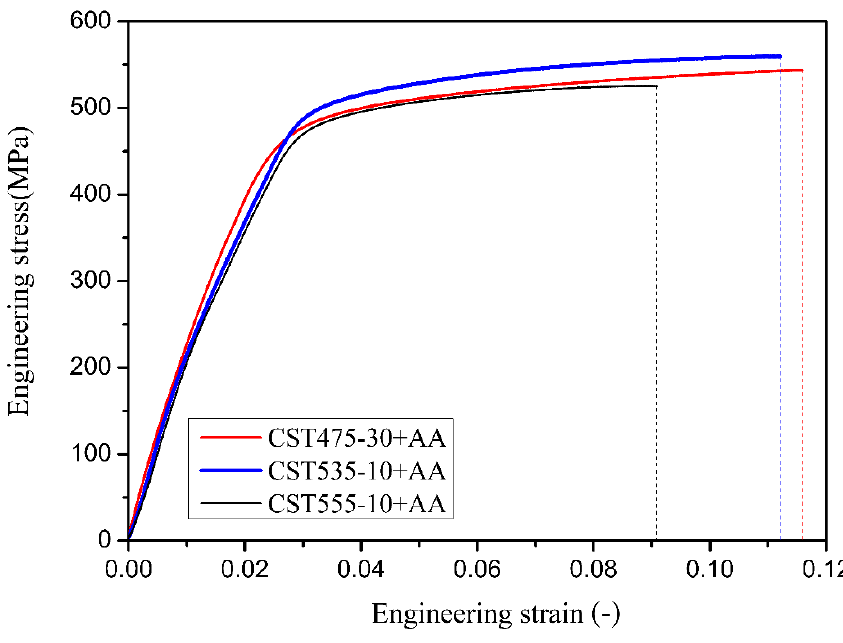
Figure 3. Engineering stress vs. strain curves at different solution temperatures. Table 3. Yield strength, tensile strength and elongation of the specimens after ageing treatment with different solution temperatures.